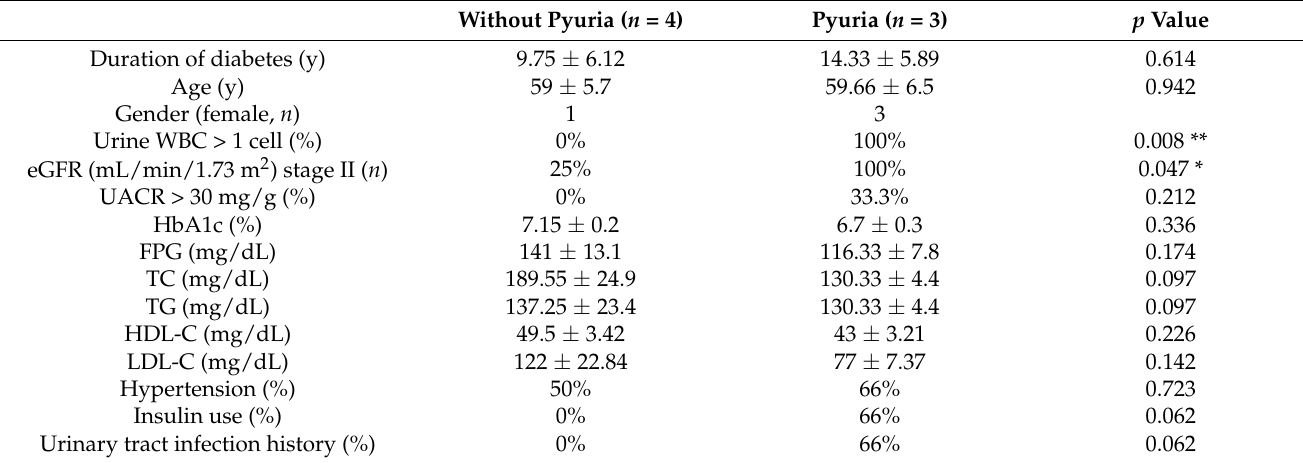
Table 1. Clinical characteristics of T2D patients treated with SGLT2 inhibitor.